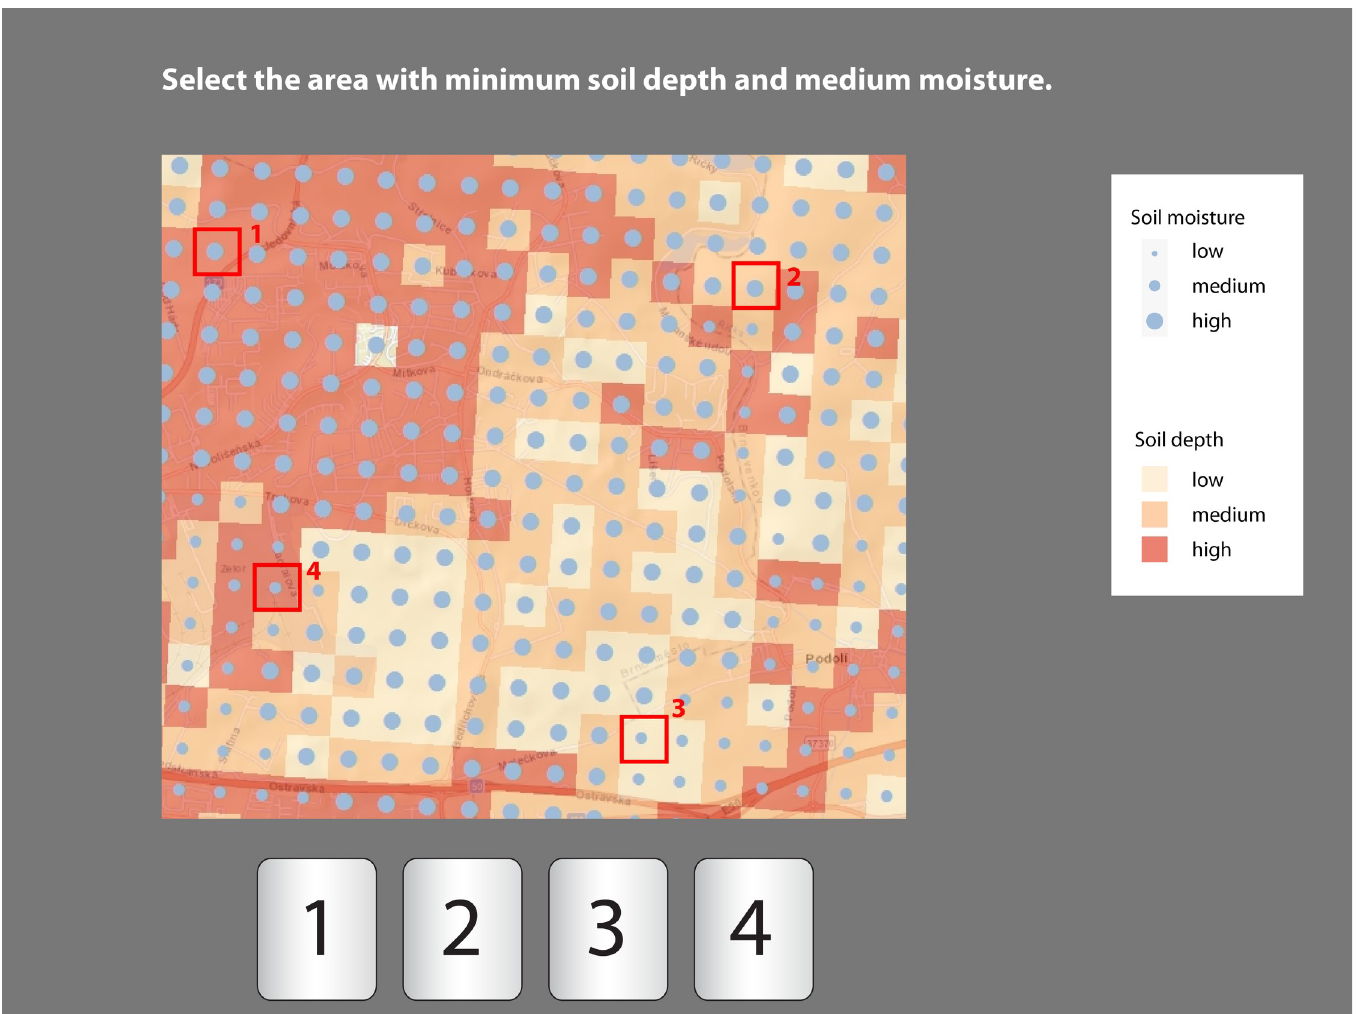
Fig 4. Example of an extrinsic visualization item (subtest B—part B.2). The task was to select the area which best satisfied the conditions of “low soil depth” and “medium soil moisture”; the correct answer was area No. 3.